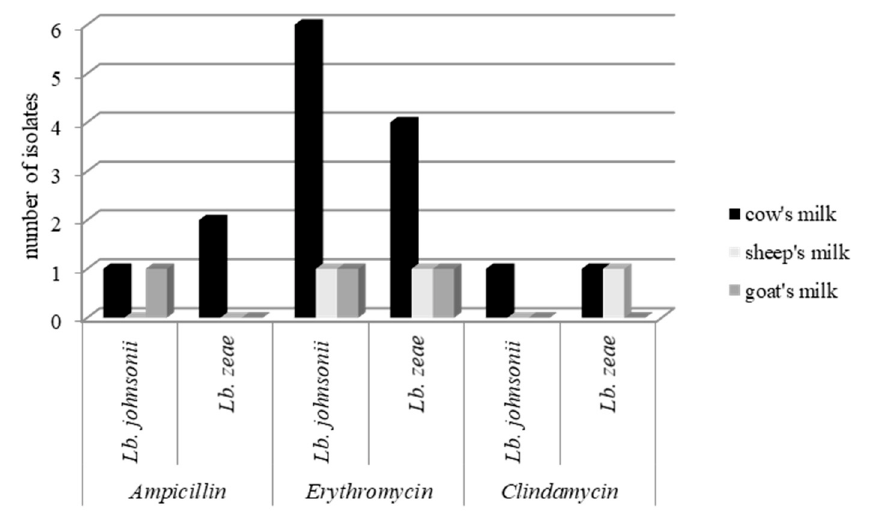
Figure 4. Number of resistant strains in each type of milk.